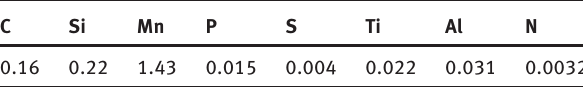
Table 1: Composition of Ti-bearing ship plate steel examined, mass%